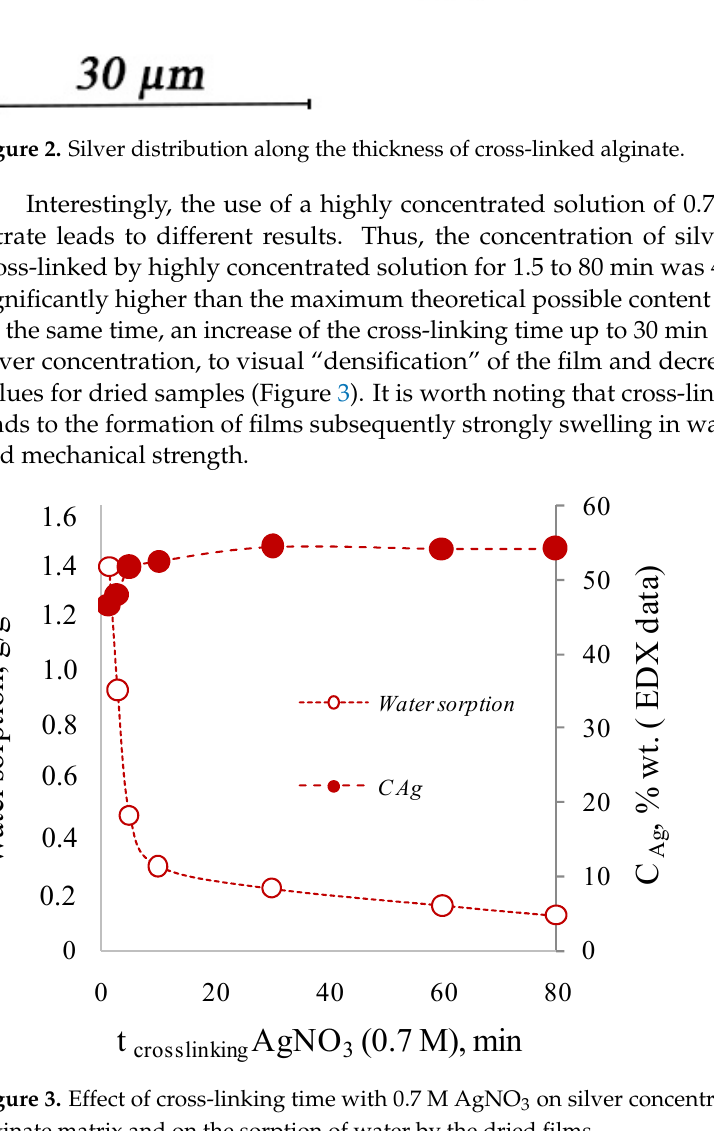
Figure 3. Effect of cross-linking time with 0.7 M AgNO 3 on silver concentration in the cross-linked alginate matrix and on the sorption of water by the dried films. The concentration of silver in the polymer exceeding the theoretically calculated 38% wt. means that in addition to the stoichiometric substitution of sodium cations for silver cations there is an additional introduction of silver into the polymer. The mechanism of this excessive “introduction” of silver cations can be explained by a number of spectra (Figure